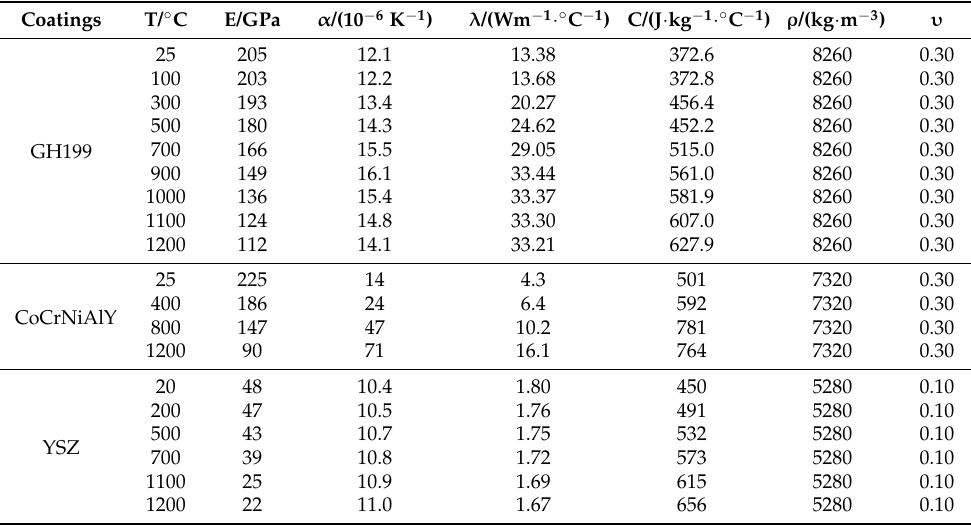
Table 4. Material parameters of coating